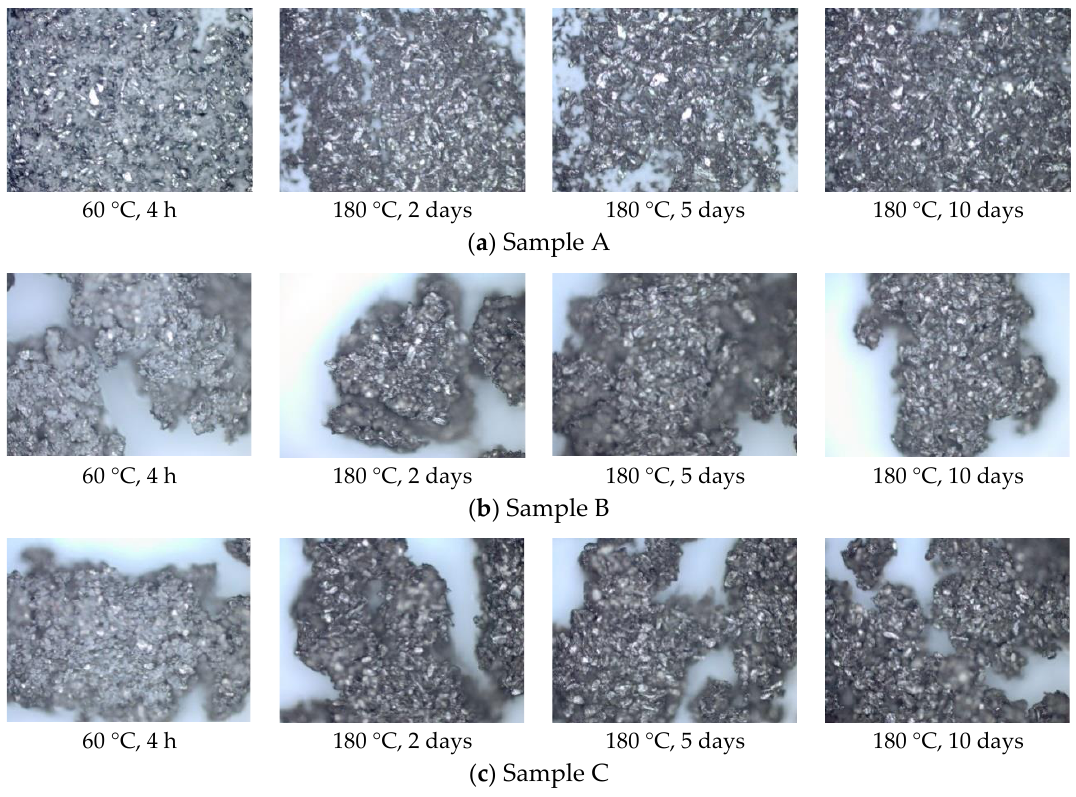
Figure 1. The apparent morphology of three kinds of Mg/TeO 2 ignition composition before and after different temperature tests (enlarged 100 times).